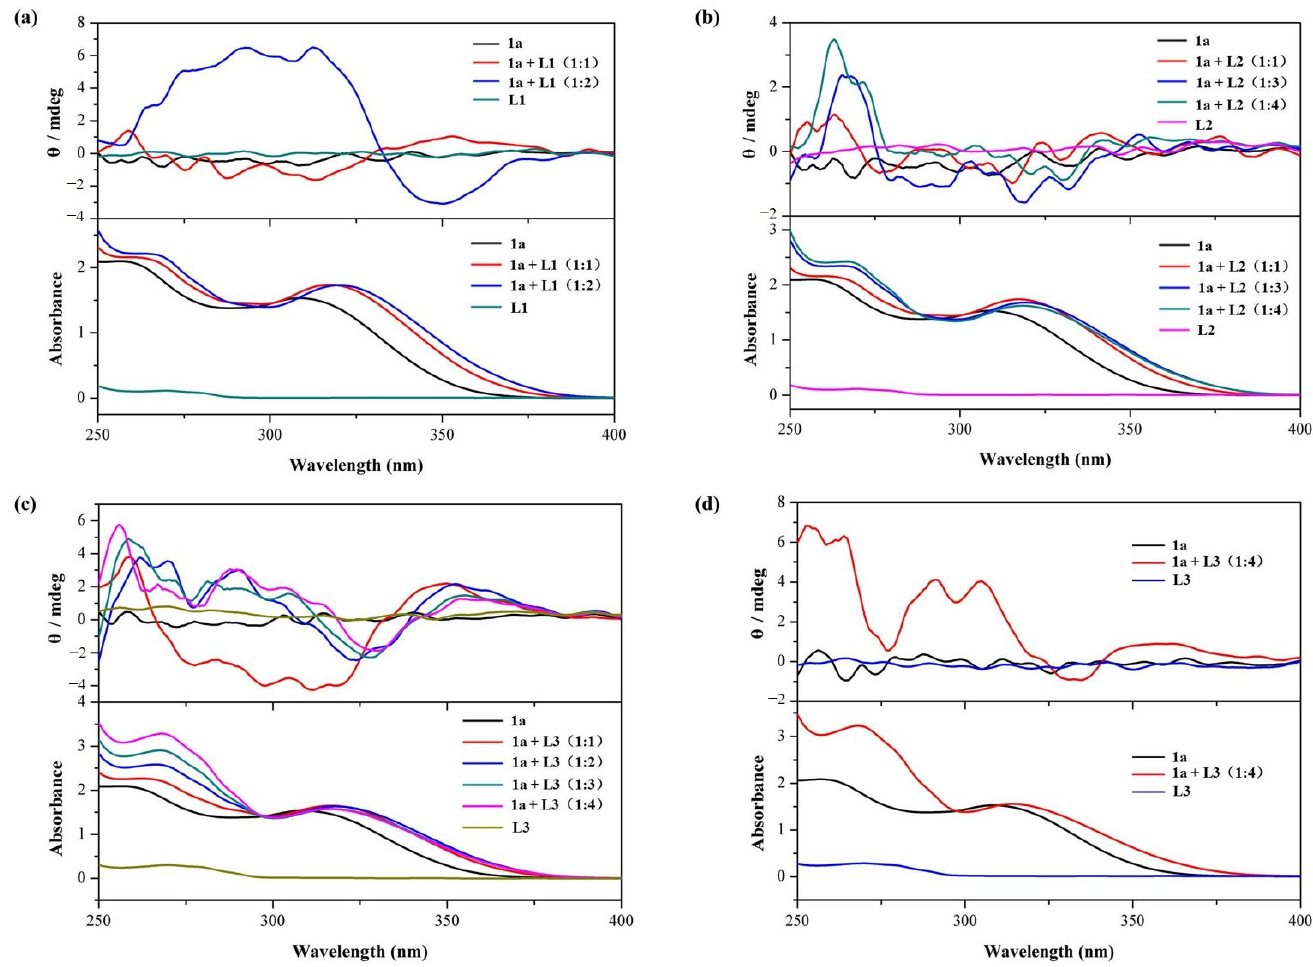
Figure 2. Circular dichroism (CD) spectra and corresponding UV-vis spectra of 1a (25 μ M) in CHCl 3 at 298 K upon the addition of amino acid derivatives: ( a ) L1 (0 to 2 equivalents, optical path of cell: 10 mm); ( b ) L2 (0 to 4 equivalents, optical path of cell: 10 mm); and ( c ) L3 (0 to 4 equivalents, optical path of cell: 10 mm). ( d ) CD spectra and corresponding UV-vis spectra of 1a (250 μ M) in CHCl 3 at 298 K upon addition of L3 (0 and 4 equivalents, optical path of cell: 1 mm).